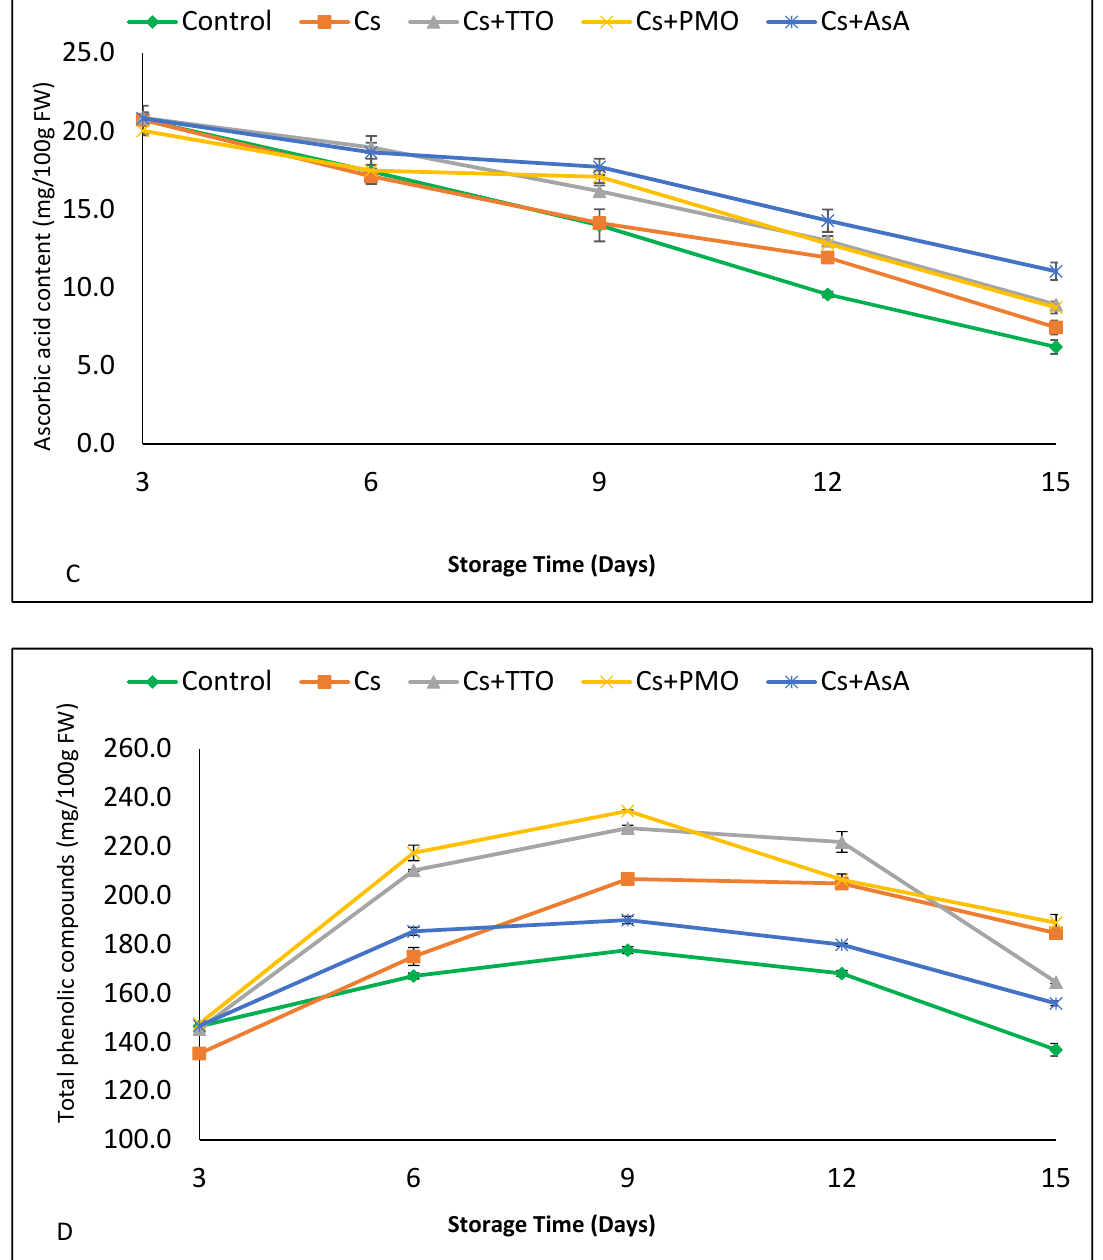
Figure 2. Effect of chitosan (Cs), Cs + tea tree oil (Cs + TTO), Cs + peppermint oil (Cs + PMO), and Cs + ascorbic acid (Cs + AsA) on ( A ) TSS, ( B ) total chlorophyll, ( C ) AsA, and ( D ) total phenolic compounds of fresh-cut green bean pods stored for 15 d at 5 °C. Error bars = SE, n = 6. Total chlorophyll of FC-GB decreased over storage time in all treatment groups (Figure 2b). There was no difference between treatments after 3 d of storage; however, FC-GB treated with Cs + TTO and Cs + PMO had significantly higher total chlorophyll compared to the control and Cs + AsA at the end of storage. Indeed, Cs + PMO maintained total chlorophyll content at levels equivalent to values seen in the control sample three days earlier, between 6 d and 15 d of storage (Table S1). In addition, FC-GB treated with Cs alone and Cs + AsA had a higher chlorophyll content than the control after 15 d of storage. The AsA content of FC-GB decreased over storage time (Figure 2c). However, from 3 d to 6 d of storage, AsA levels did not fall by a significant amount in any